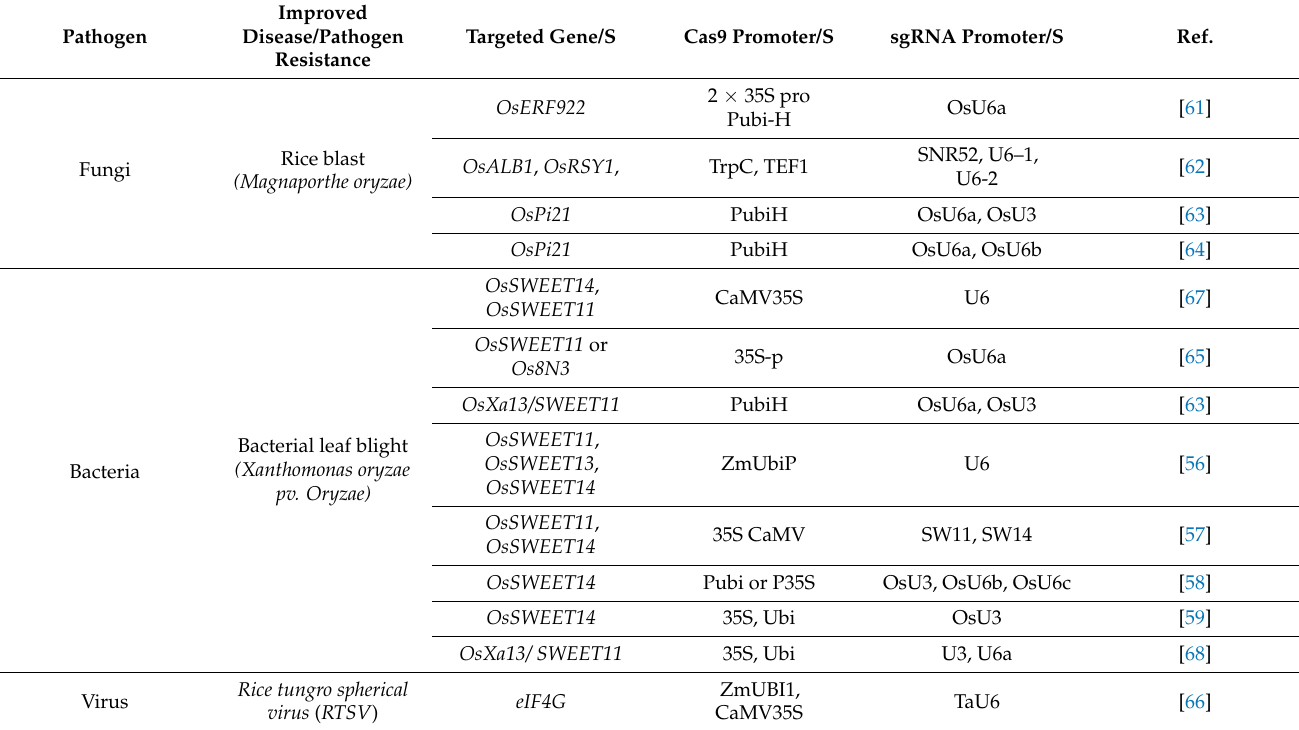
Table 3. Examples of CRISPR/Cas9 system for enhancing the disease resistance of